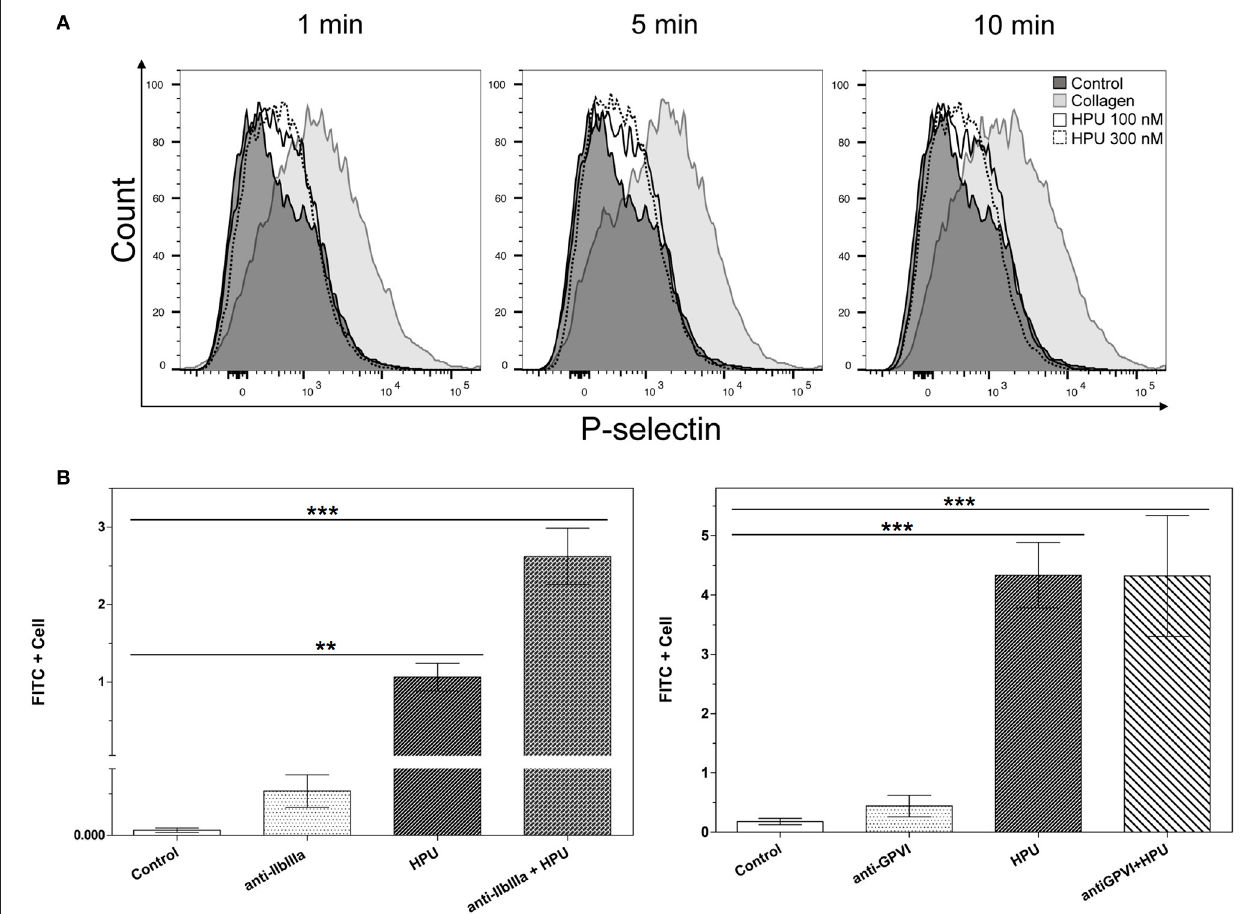
FIGURE 4 | Urease interaction with platelet membrane receptors. Representative flow cytometry histograms of P-selectin exposure on platelets’ membranes of non-treated (control), collagen- or HPU-treated cells, at three different times (1, 5, and 10min), are shown in (A) . The bar graph in (B) shows the mean percentage of FITC positive cells. Platelets were pre-treated with anti-GPVI or anti-IIbIIIa for 20min and then challenged with 50nM FITC-labeled HPU. Data are means ± SEM. Statistical significance was determined by ANOVA followed by Tukey-Kramer test. Values of ** p < 0.01, *** p <